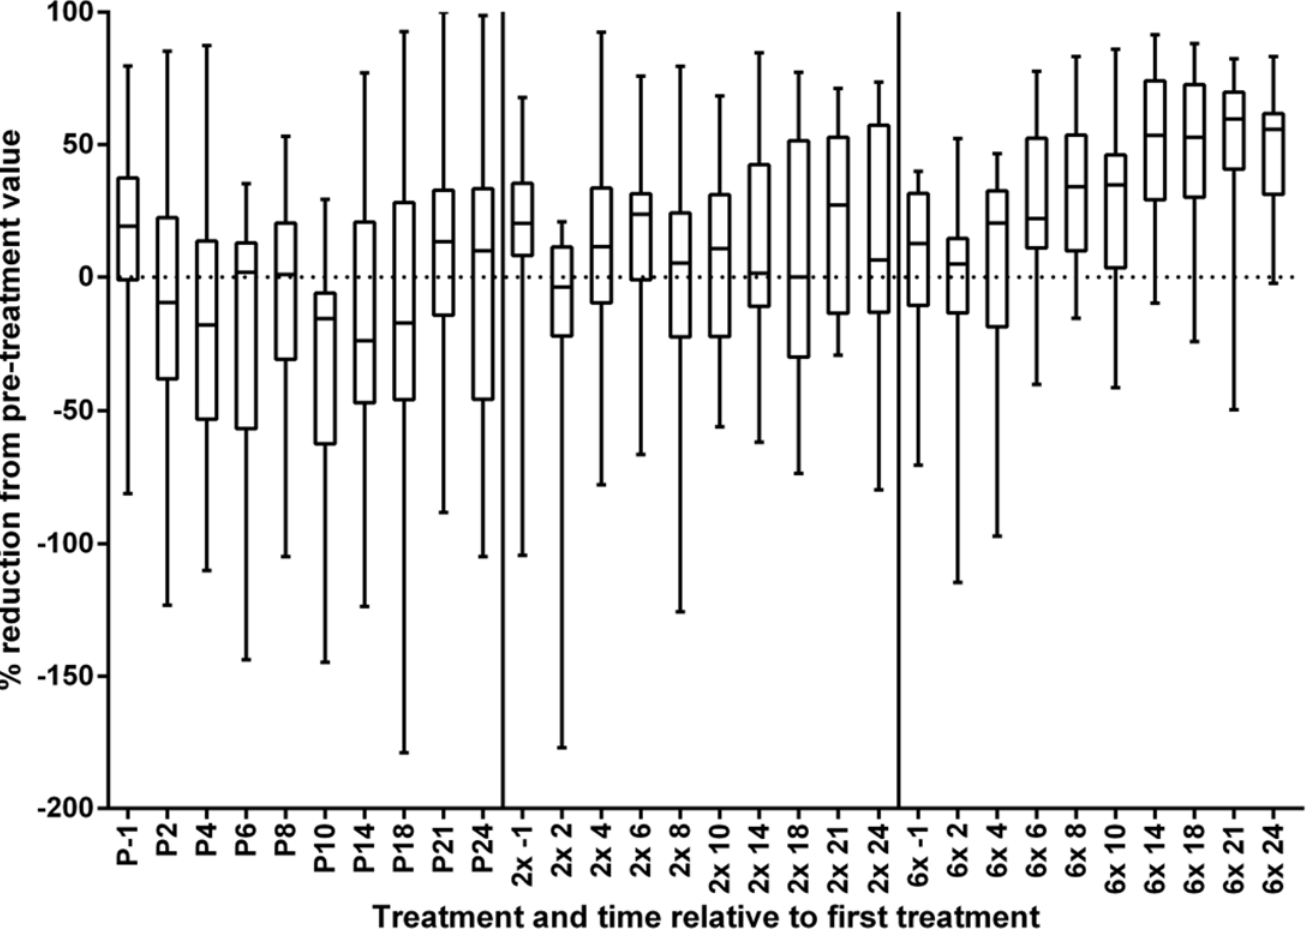
Fig 3. Minimum, 25%, 50th, 75th percentile and maximum of the % reduction from pre-treatment values. P placebo, 2x 2 doses albendazole, 6x 6 doses albendazole, -1 value obtained during screening (4 – 12 weeks prior to baseline measurement and first treatment), 2, 4, 6, 8, 10, 14, 18, 21, 24 Months after the first treatment at which LLM was measured.